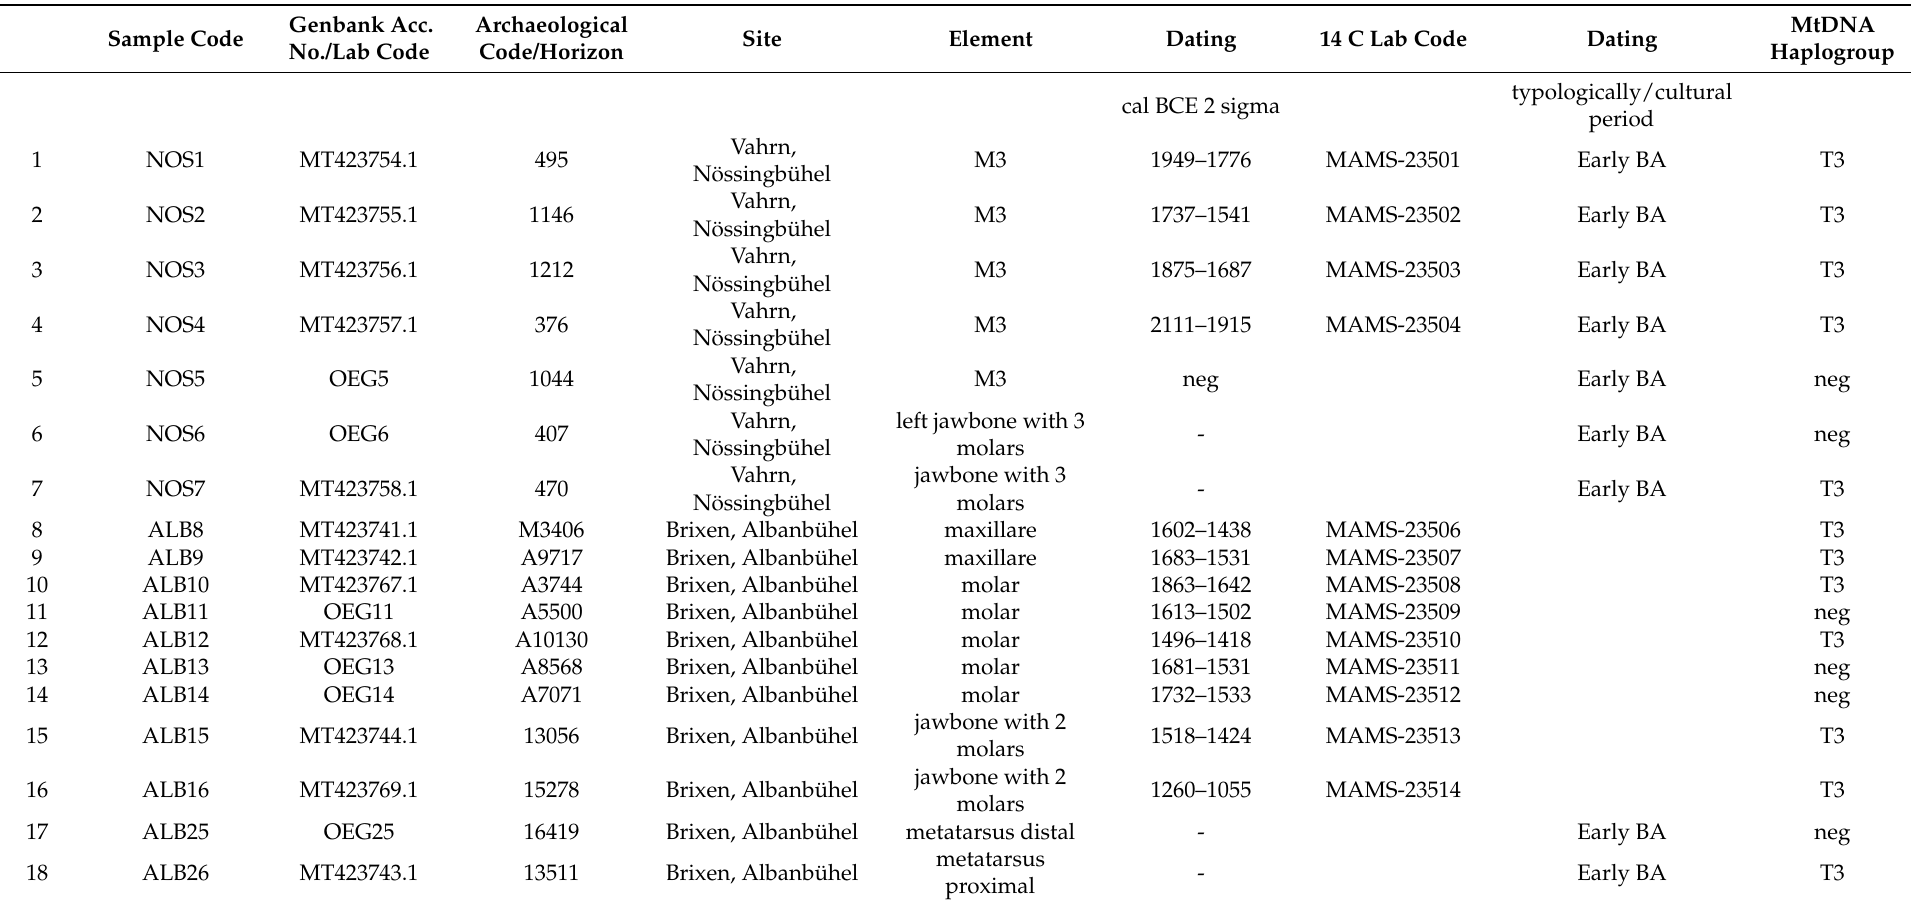
Table 1. Details of cattle samples and haplogroup identification. 14 C datings from Savognin Padnal were taken from Bopp-Ito, M. Animal husbandry in the Bronze Age Alpine settlement “Savognin Padnal”, Switzerland: a preliminary study. In Proceedings of the General Session of the 11th International Council for Archaeozoology Conference (Paris, 23–28 August 2010), Lev è vre, C., Ed. BAR International Series 2012; Vol. 2354, pp. 75–85. BA = Bronze Age; - = no